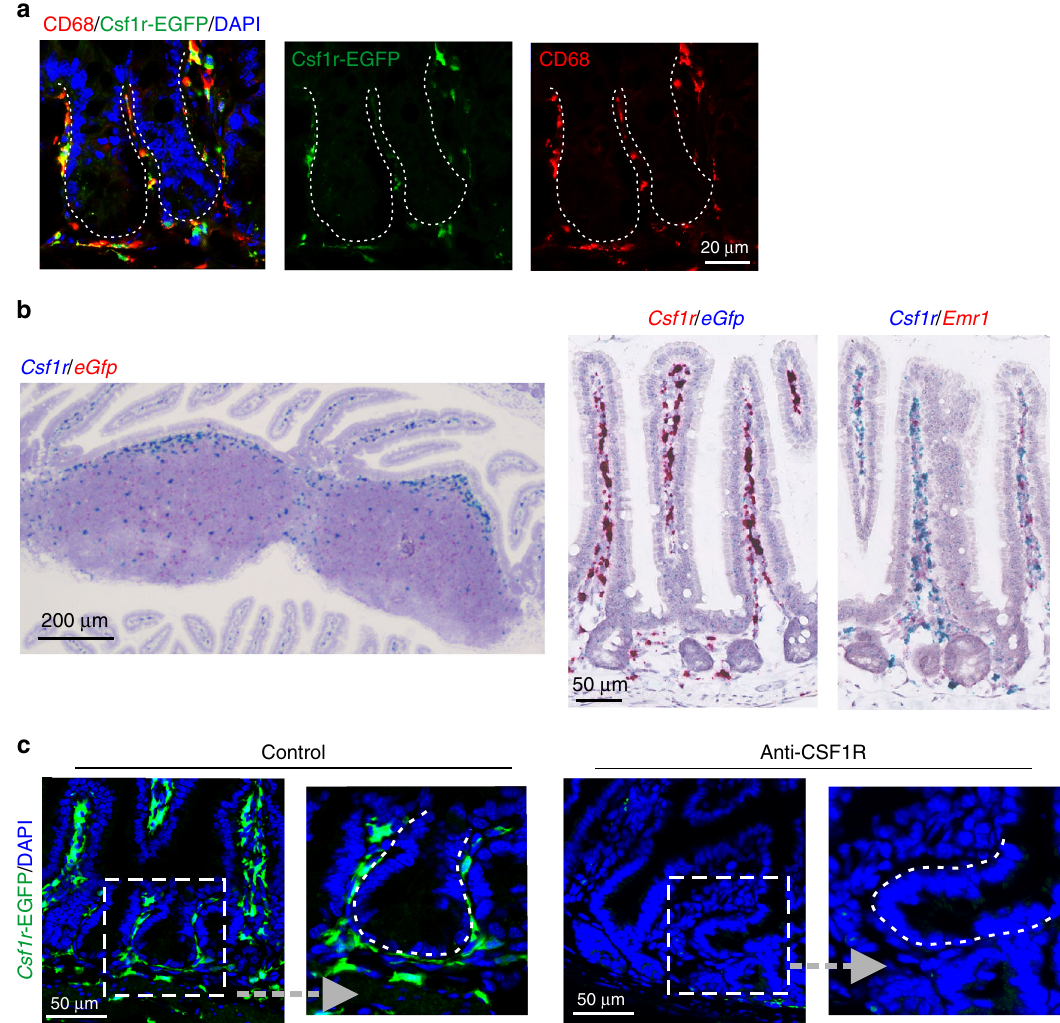
Fig. 4 Macrophages are the only cells which express CSF1R within intestinal crypts. a IHC analysis shows Csf1r -EGFP + CD68 + macrophages are in direct intimate contact with the crypt epithelial cell layer. Scale bar, 20 µ m. b Left-hand panel shows the distribution of Csf1r (blue) and eGfp (red) mRNA expression in Peyer ’ s patches. Scale bar, 200 µ m. In the gut wall Csf1r (red, middle panel; blue, right-hand panel) and eGfp (blue) mRNA expression was only expressed by macrophages ( Emr1 , red; right-hand panel). Scale bar, 50 µ m. c IHC analysis shows that in the crypts and gut wall of Csf1r -EGFP mice, Csf1r -EGFP + macrophages (green) were depleted after CSF1R blockade. Sections in a , c were counterstained with DAPI to detect cell nuclei (blue). Broken lines indicate the crypt epithelial cell layer boundary. Scale bar, 50 µ m. Representative images are shown from 3 to 4 intestinal segments from 4 to 8